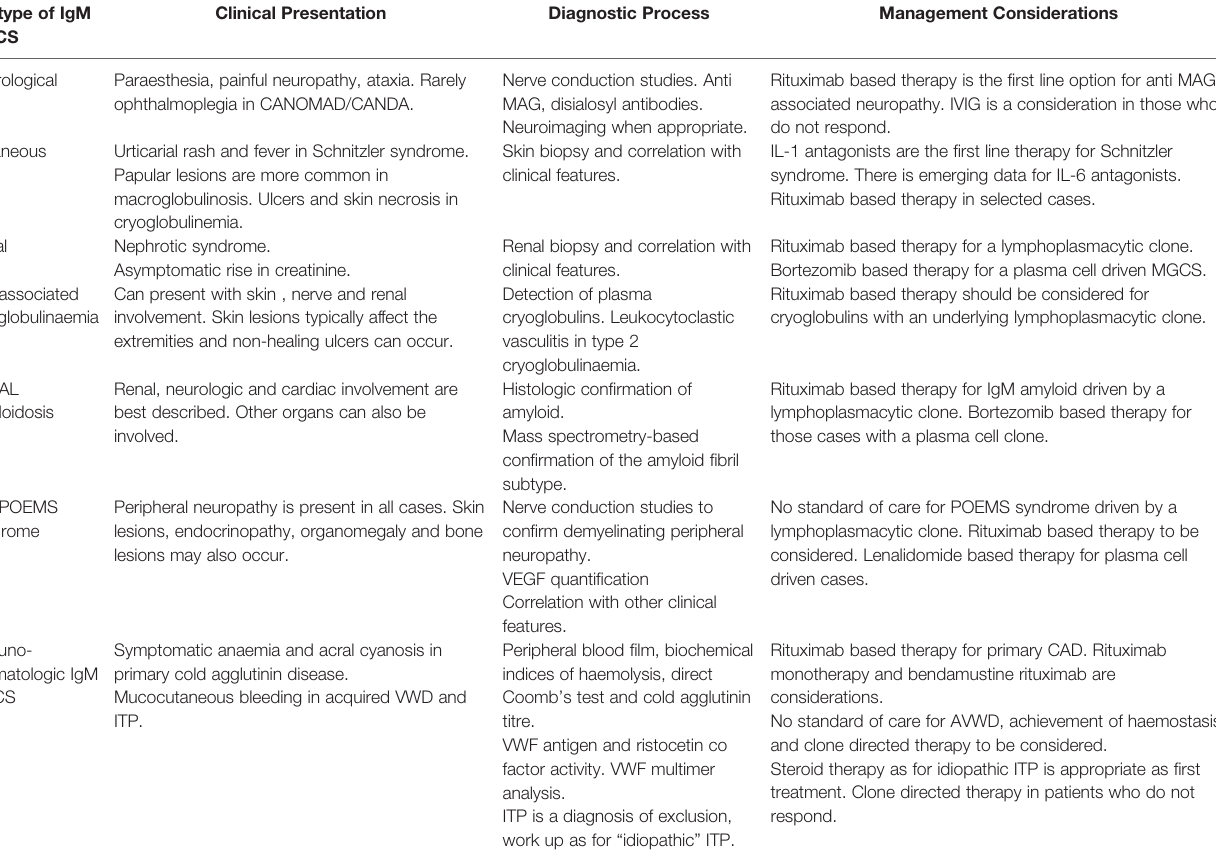
TABLE 1 | An overview of the key clinical features, diagnostic and management considerations in IgM monoclonal gammopathy of clinical signi fi cance